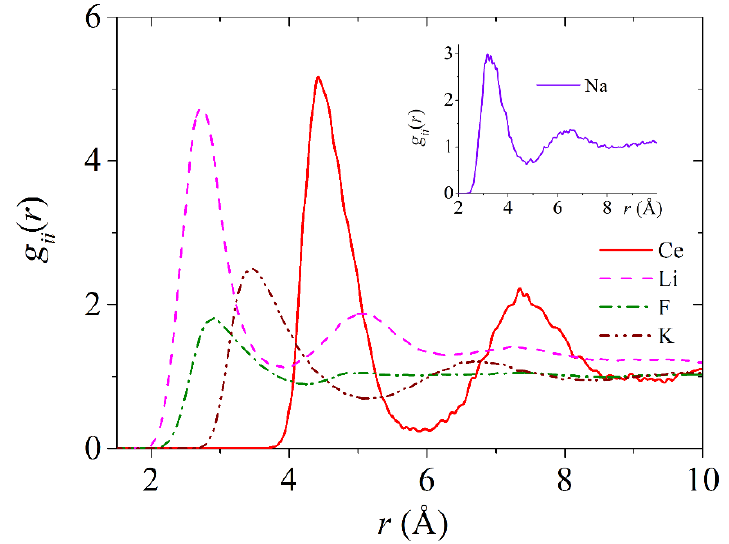
Figure 7. The partial radial distribution functions of Li–Li, Na–Na (in the insert), K–K, F–F and Ce–Ce at 950 K.